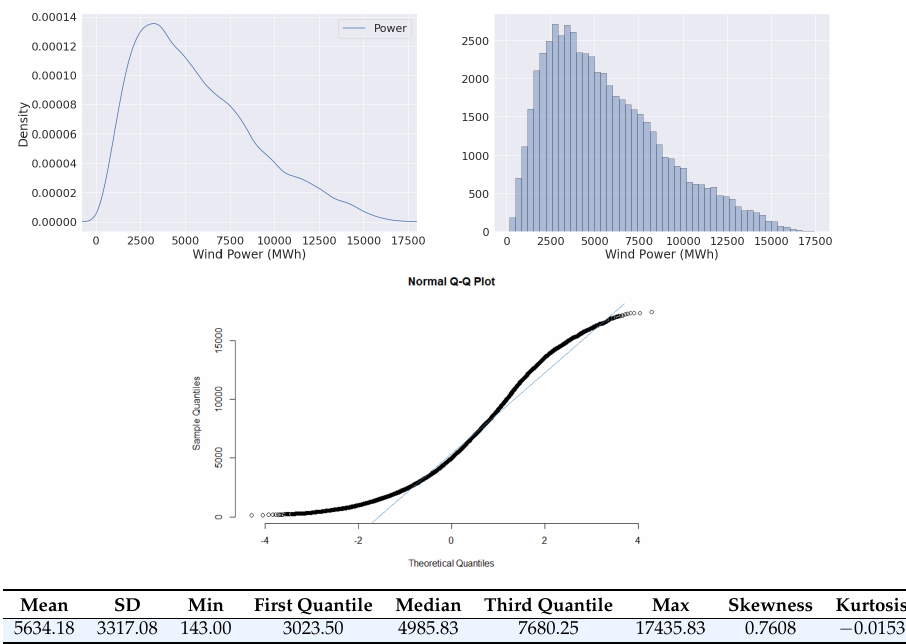
Figure 2. Kernel density plot, histogram, QQ plot, and descriptive summary of time series